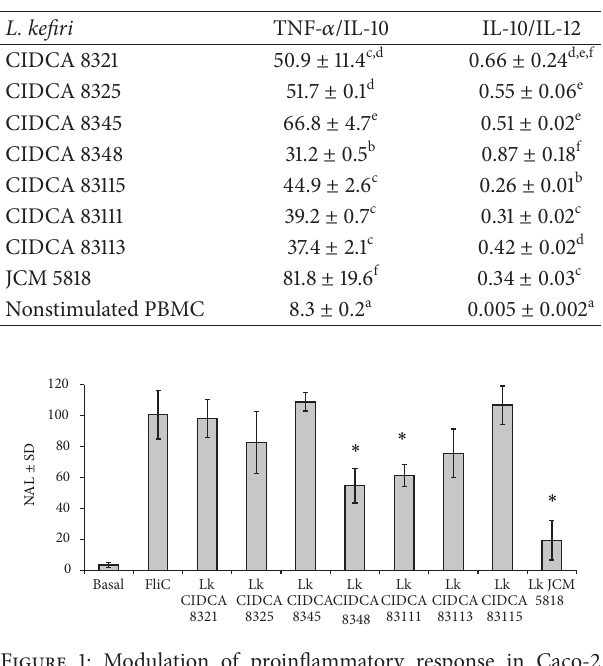
Table 3: TNF- 𝛼 /IL-10 and IL-10/IL-12ratio determined after in vitro PBMC stimulation with L. kefiri strains. Means with the same letter for each parameter are not significantly different.